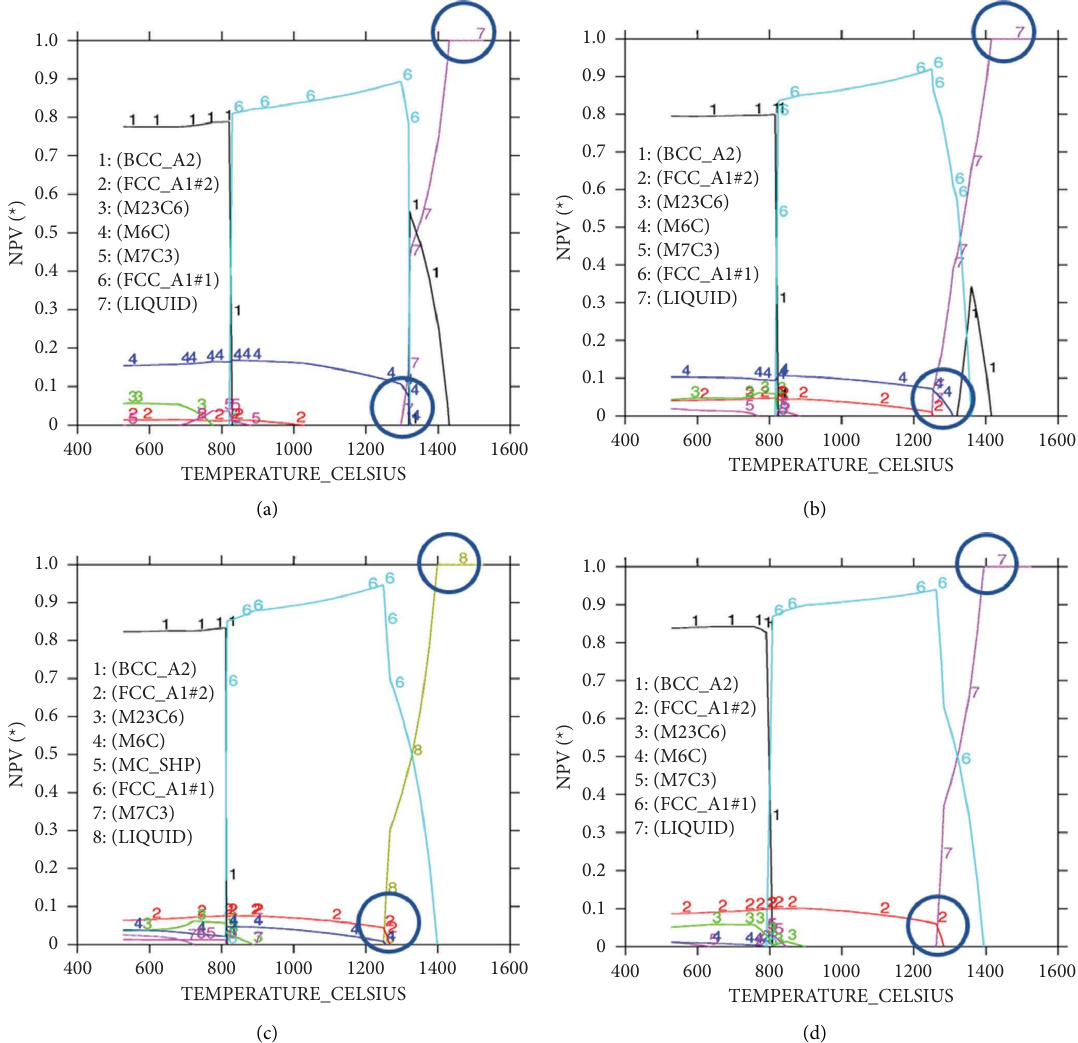
Figure 2: Solidifcation path of T1 high-speed tool steel and vanadium with extra carbon-modifed variants. (a) 1V-18W; (b) 2V-13W-HC; (c) 3V-8W-HC; (d) 4V-3W-HC.